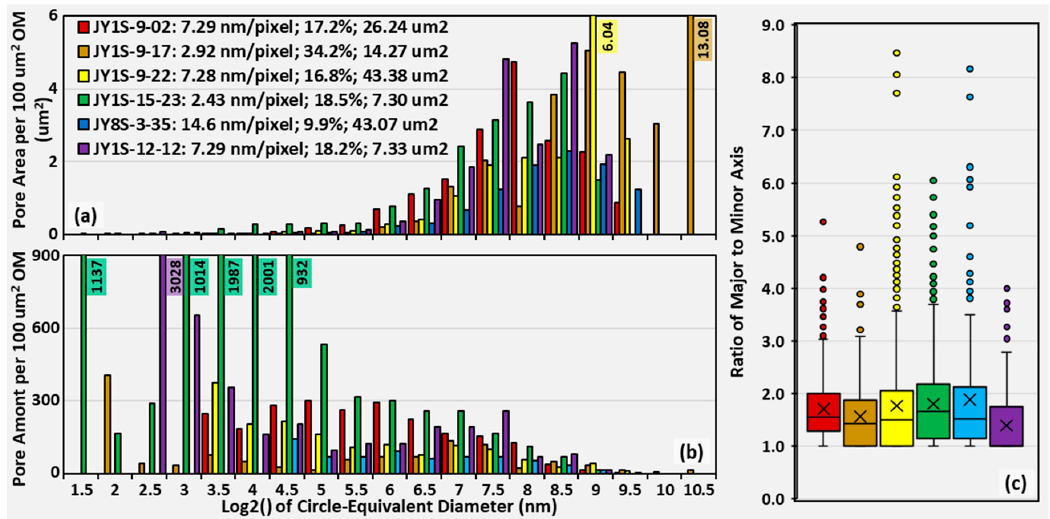
Figure 5. The pore size distribution (PSD) and geometry of OM-hosted pores within the first subtype of weakly or undeformed porous pyrobitumen (OM I) of Longmaxi-Wufeng Shale, eastern Sichuan Basin. ( a ) PSD determined by pore sectional area; ( b ) PSD determined by pore amount; and ( c ) ratio of major to minor axis. The three values after image ID in the legend are image resolution (nm/pixel), organic porosity (%), and OM sectional area (µm 2 ). The number labels show the values that are beyond the range of the vertical axis.